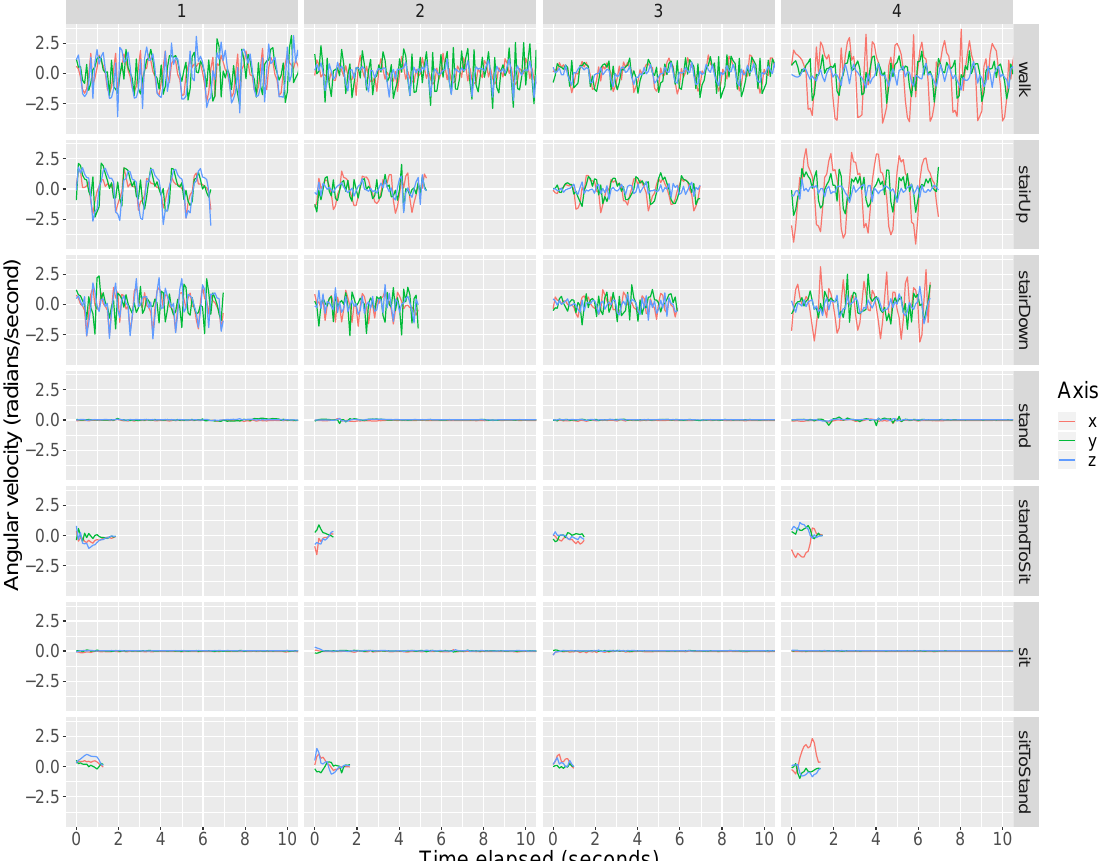
Figure 2. Training data (tri-axial) from the front pocket smartphone gyroscope. The raw tri-axial data ( x = red, y = green, z = blue) from the front pocket gyroscope is shown. The columns indicate the participant ID number and the rows indicate the activity being performed. For the activities of “standToSit,” “sit,” and “sitToStand,” we plot the data from the first of the two chair-stands. In our dataset, the coordinate system for the x, y, and z axes is as follows. If you are viewing the phone by holding it in its upright position, the x-axis runs from left to right, the y-axis runs from bottom to top, and the z-axis runs through the screen towards you. To determine the direction of a rotation about any given axis, take your right hand and point your thumb in the positive direction of the axis and then curl your fingers. By doing this, your fingers will point in the direction of a positive rotation (i.e., positive angular